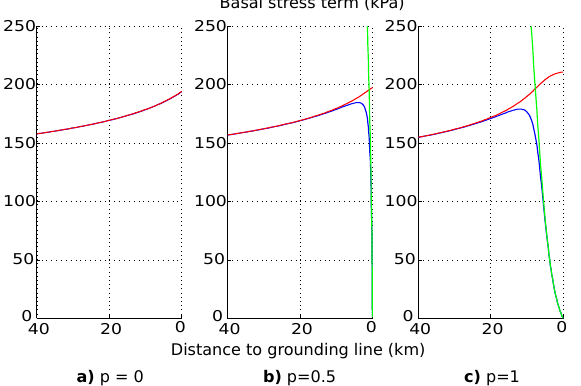
Figure 3. Basal stress given by Eq. (15) (blue) and its asymp- totic limits, Eq. (16) (red) and Eq. (17) (green) for ice softness A = 10 − 25 Pa − 3 s − 1 and using the Chebyshev benchmark solution. (a) When p = 0, the second (green) asymptote is never reached, the red and blue curves overlap almost exactly, and there is no friction transition zone (basal stress falls abruptly to zero at the grounding line). (b) and (c) When p = 0 . 5 and p = 1, the length of the fric- tion transition zone, defined as the region where 0 ≤ N(p) n ≤ κ | u | (roughly speaking, the region where the blue curve differs from the red curve), ranges from several hundred meters to 20km depending on A , p and bedrock topography.